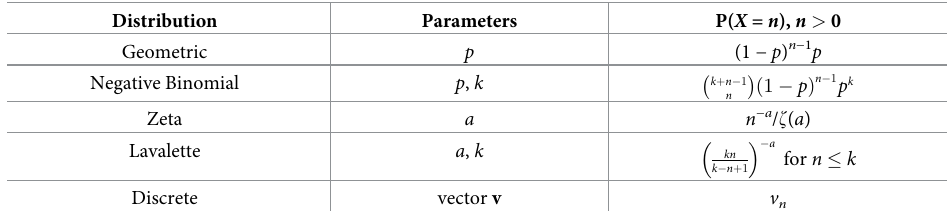
Table 1. Indel length distribution